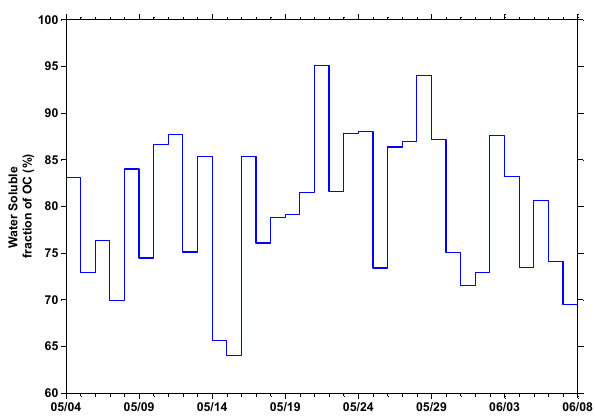
Fig. 9. Percentage of water soluble OC based on PM 1 filter mea- surements. On average 80% of OC was water soluble.